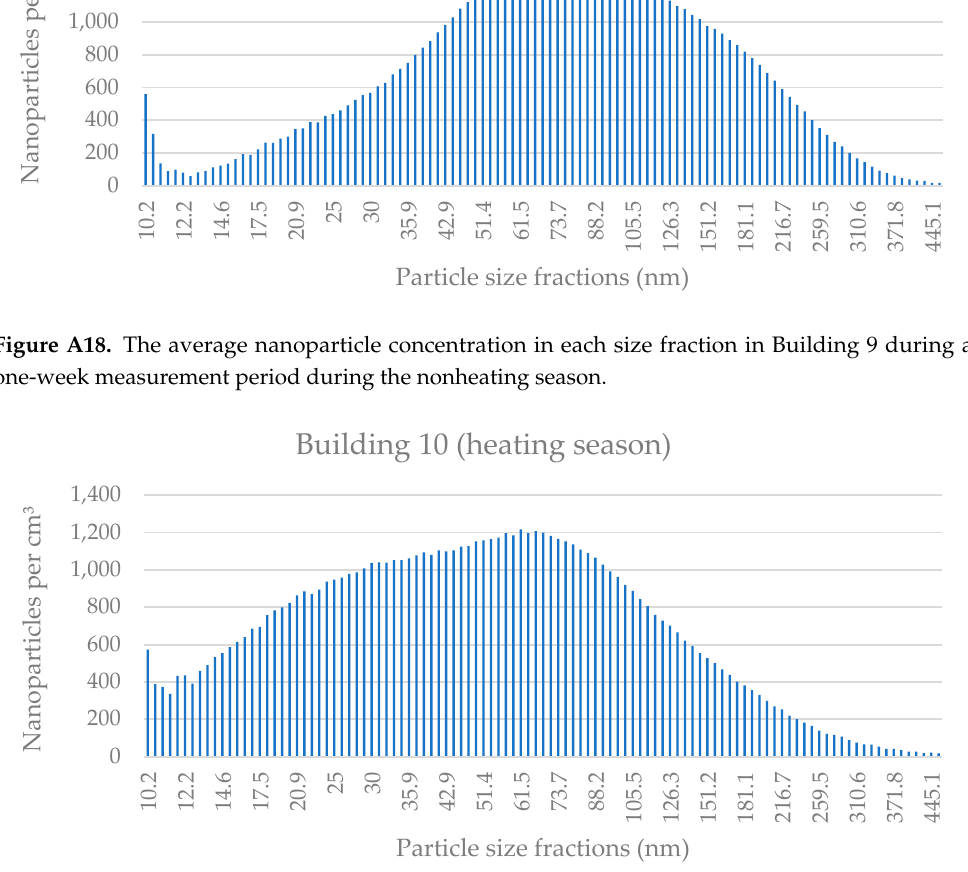
Figure A19. The average nanoparticle concentration in each size fraction in Building 10 during a one-week measurement period during the heating season.